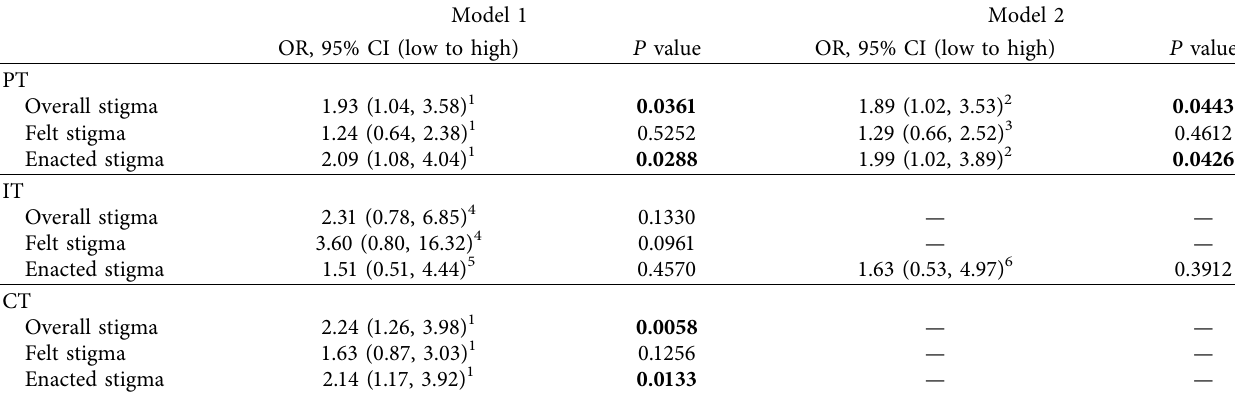
Table 6: Multivariable linear regression analyses for PT, IT, and CT in overall stigma, felt stigma, and enacted